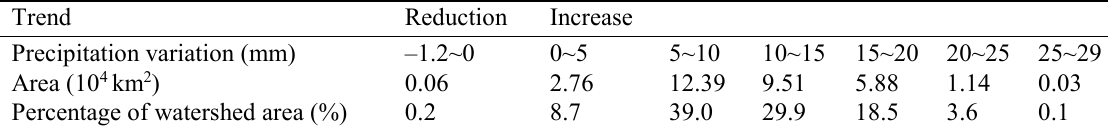
Table 1 Spatial variation of precipitation in May.